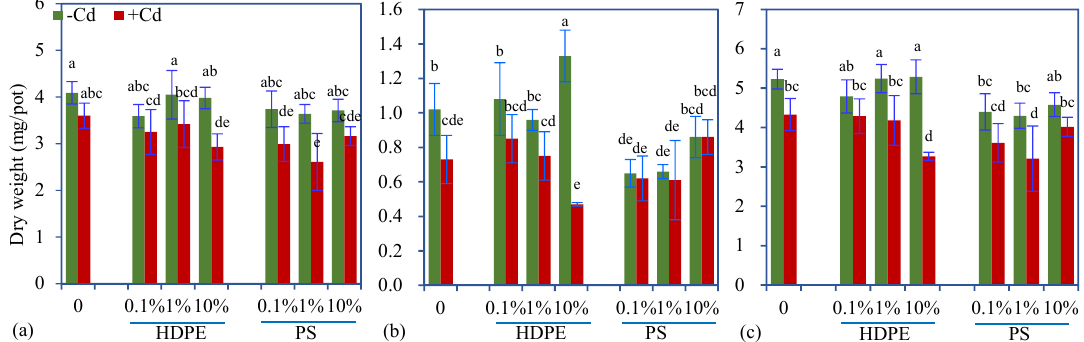
Figure 1. Shoot ( a ), root ( b ) and total ( c ) dry weights (mean ± SE, n = 4) of maize plants exposed to microplastics (MPs) with or without Cd. +Cd and ‐ Cd represent the treatments with or without 5 mg/kg Cd, respectively. Different letters over the bars indicate significant differences using a one ‐ way ANOVA followed by Duncan’s multiple range test ( p < 0.05). Two ‐ way and three ‐ way ANOVA results are shown in Tables 2 and 3, respectively. Table 2. E ff ects of MPs, Cd, and their interactions on measured variables based on a two-way ANOVA